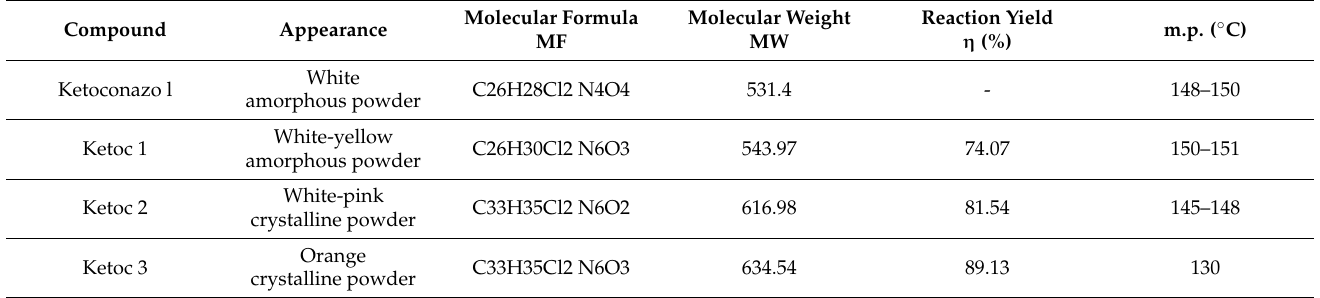
Table 1. Physico-chemical characterization of ketoconazol vs. new compounds.